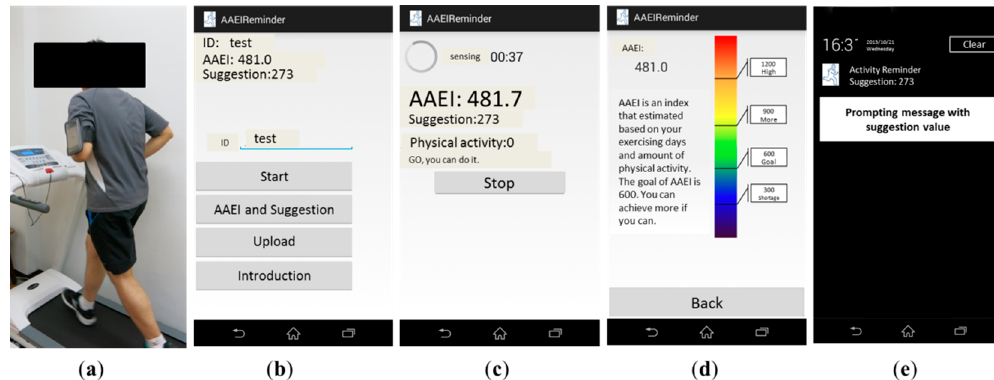
Figure 11. ( a ) The mobile phone is placed on the left upper arm while doing physical activity; ( b ) the screenshot of AAEI feedback and prompting suggestion before physical activity; ( c ) the screenshot of AAEI feedback and prompting suggestion when doing physical activity; ( d ) an introduction to the AAEI value for the user; ( e ) a delivered prompting message.